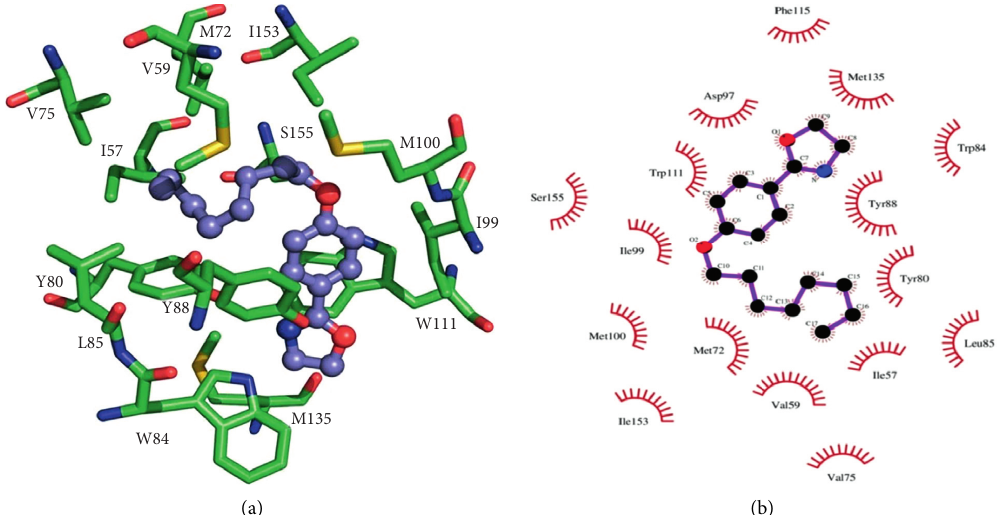
Figure 11: A 2D schematic diagram of the interaction between 17 and CviR.